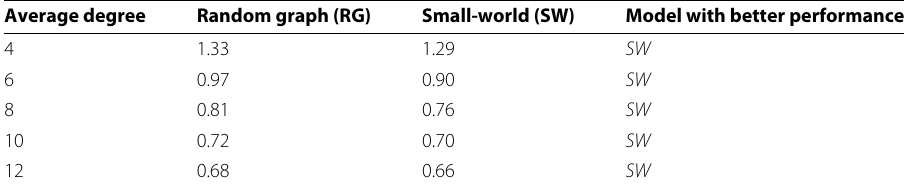
Table 4 Performance comparison of Maximum Load between the small-world and the random graph Average